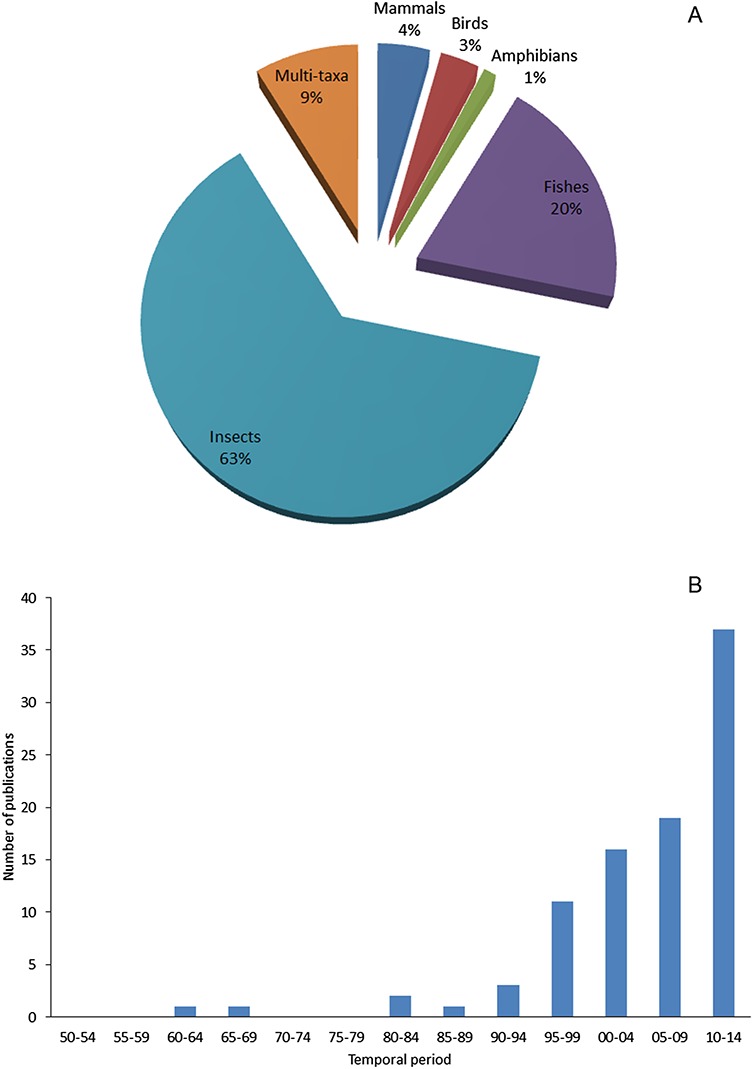
(A) Taxonomic structure of case studies on animal invasions in Xinjiang and (B) Trend of the number of publications on animal invasions in Xinjiang during 1950 to 2014.